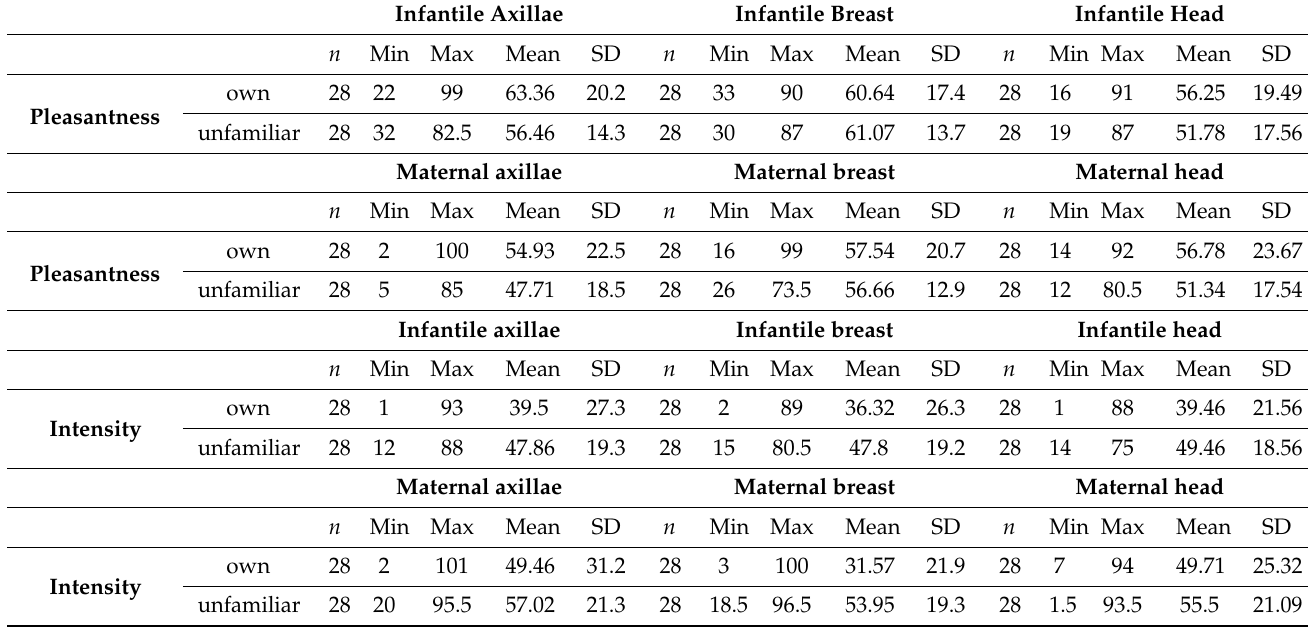
Table 2. Descriptive analyses of pleasantness and intensity ratings. n = sample size, Min = minimum value, Max = maximum value, Mean = mean value, SD = standard deviation. All BOs were rated on a visual analogue scale ranging from 0 (“not pleasant”/“not intense”) to 100 (“very pleasant”/“very